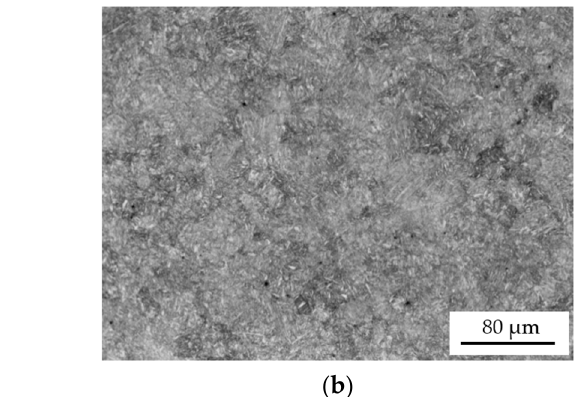
Figure 8. Microstructure of the new shaft journal (without coating). The specimen was etched with Kalling’s reagent ( a , b ).